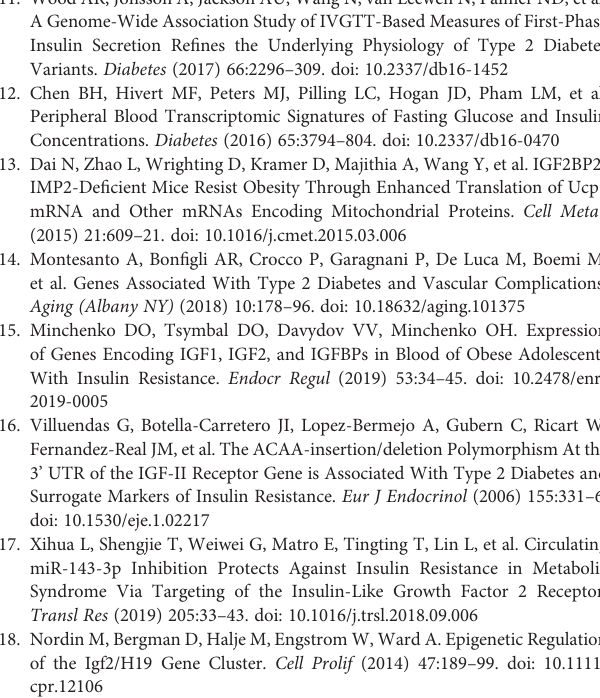
Supplementary Table 1 | PCR Primer sequences in gene